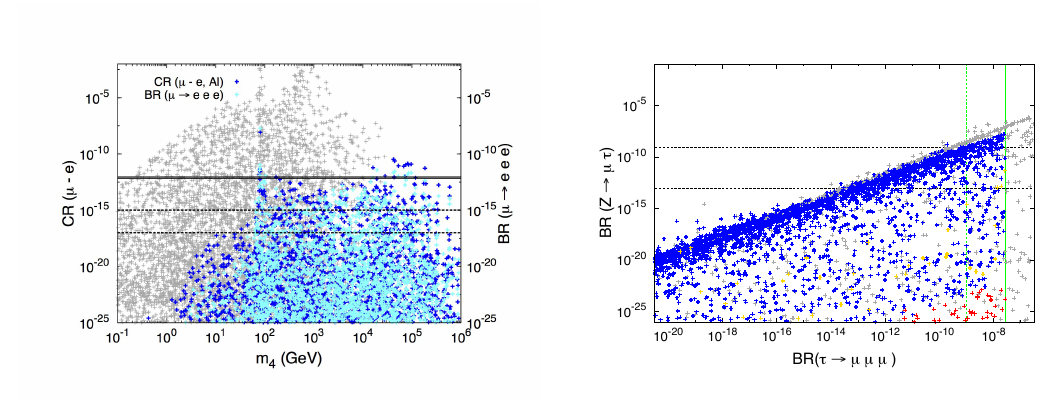
Figure 2: On the left, CR( µ − e ) and BR( µ → eee ) as a function of m mer is displayed in dark blue (left axis), while the latter is depicted in cyan (right axis). A thick (thin) solid horizontal line denotes the current experimental bound on the CR( µ − e , Au) [ 13 ] ( µ → eee decays [ 9 ] ), while dashed lines correspond to future sensitivities to CR( µ − e , N) [ 15,29 ] (from [ 30 ] ). On the right, BR( Z → τµ ) vs. BR( τ → 3 µ ); vertical lines denote future experimental sensitivities while the horizontal ones correspond to the prospects of a GigaZ facility and of the FCC-ee (from [ 31 ] ). Both cases correspond to a “3 + 1 toy model”, and in both panels grey points are phenomenologically